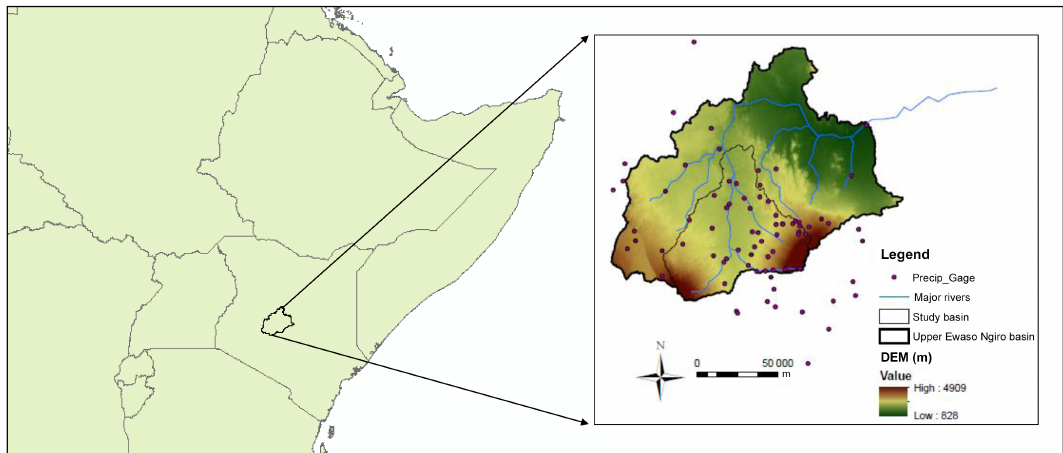
Figure 1. Map showing the general location of the upper Ewaso Ngiro river basin within the boundaries of the east sub-Saharan Africa region. The study sub-catchment (study basin) was selected because of the density of rainfall stations (points in dark